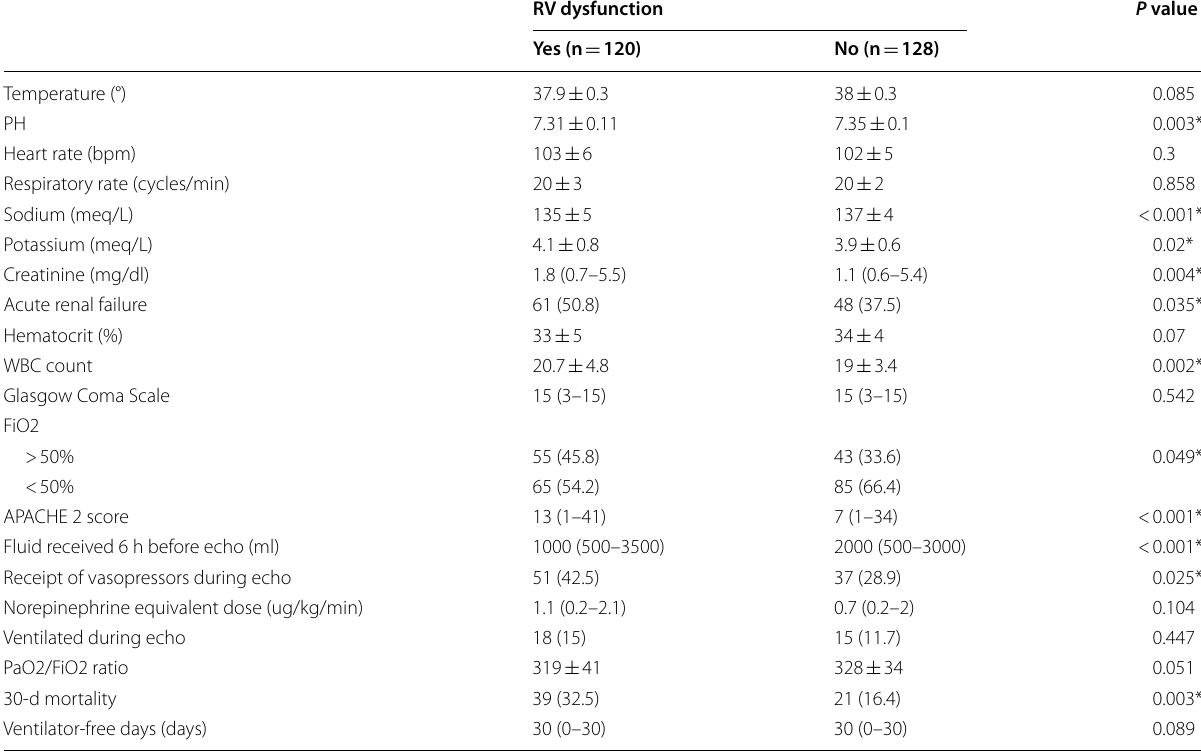
WBC, white blood cells; FiO2, fraction of inspired O2 *Significant; Data were presented as mean